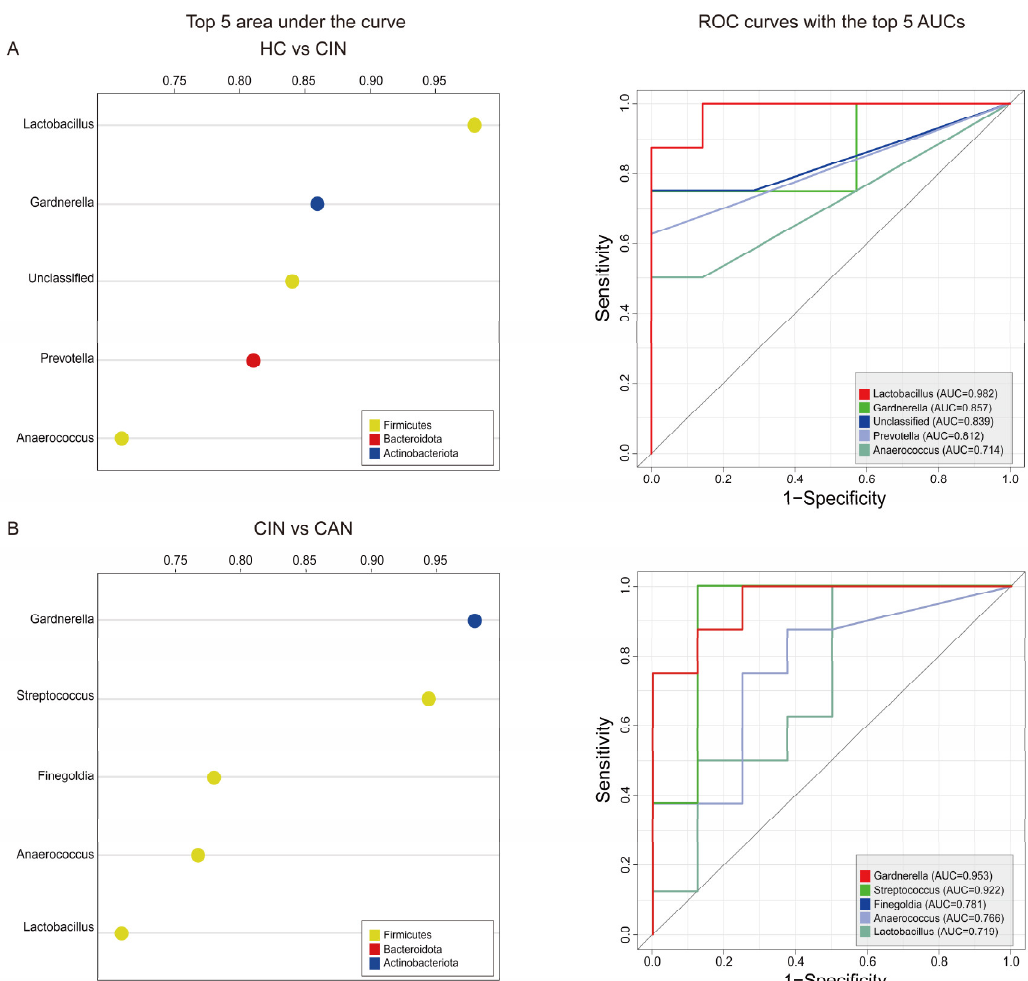
Figure 3. Evaluation of the top five bacterial genera as a noninvasive diagnostic tool to predict disease progression. ( A ) ROC analysis to compare HC with CIN. ( B ) ROC analysis to compare CIN with CAN. The left panel displays the AUC of the top five impactful genera, and the right panel presents the individual AUC of the ROC curves.